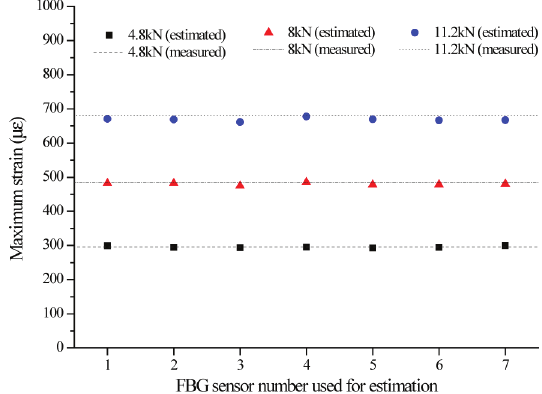
Fig. 5. Simply supported beam and hydraulic jack Fig. 7. Comparison between maximum strains estimated by an- alytical model using FBG sensor and direct measured Table 3. Comparison of the maximum strains between estimation and measurement